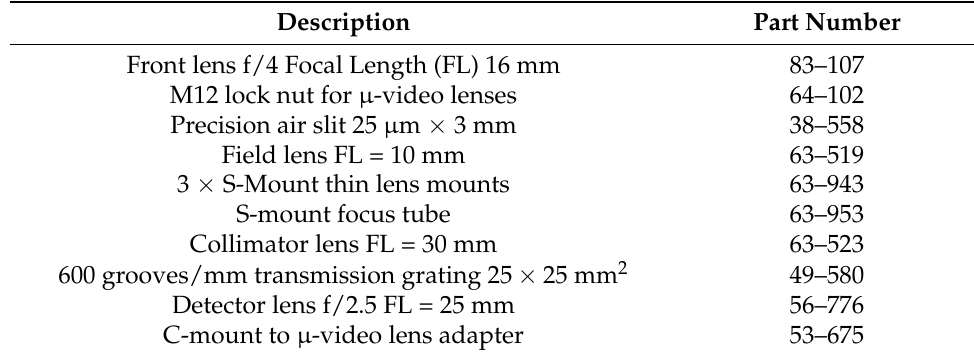
Table A1. Shopping list for the HSI. Adapted from [9]. Part numbers refer to the part numbers used on Edmund Optics website